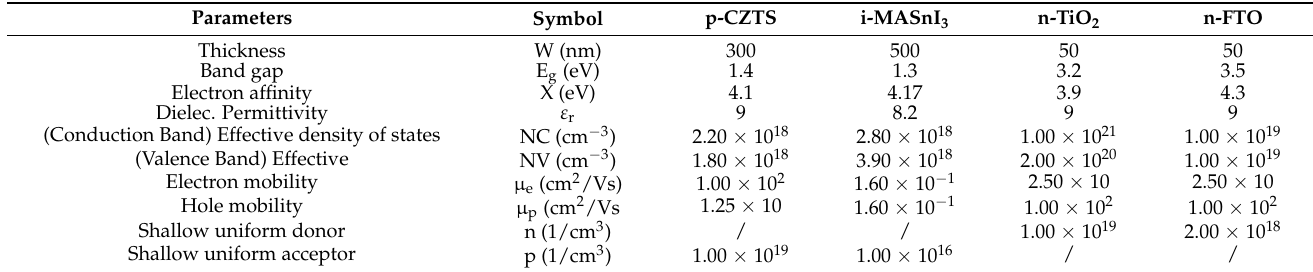
Table 2. Perovskite solar cell input optical and electric parameters [13].